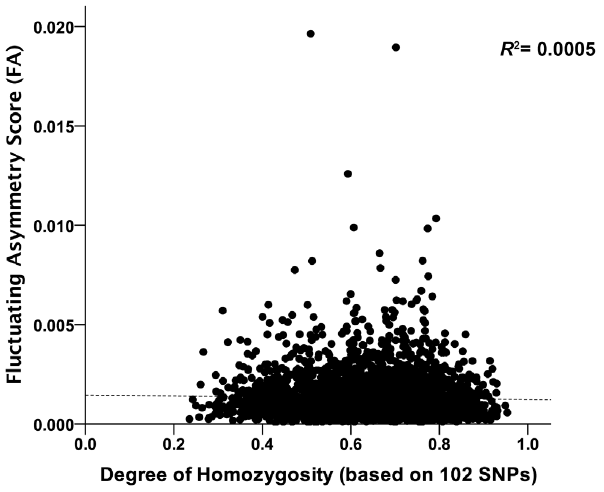
Figure 1. Lack of correlation between homozygosity by loci (HL) and Procrustes FA score ( N =3215). Individual homozygosity (based on 102 SNPs) is not correlated with facial FA inferred from the nine 3D facial landmarks previously used by Liu et al. [1]. The dashed line is the regression line ( r =0.024, p =0.17, N =3215). The same holds true for total asymmetry, because DA was very small, and thus TA and FA were strongly correlated ( r =0.98).